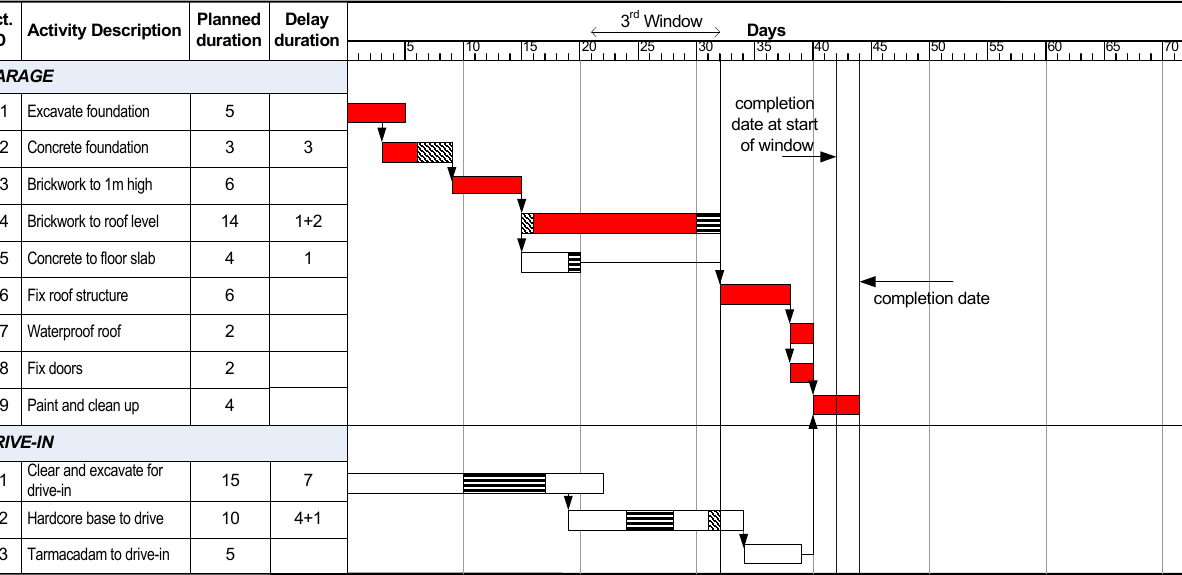
Figure 20. Updated schedule on day